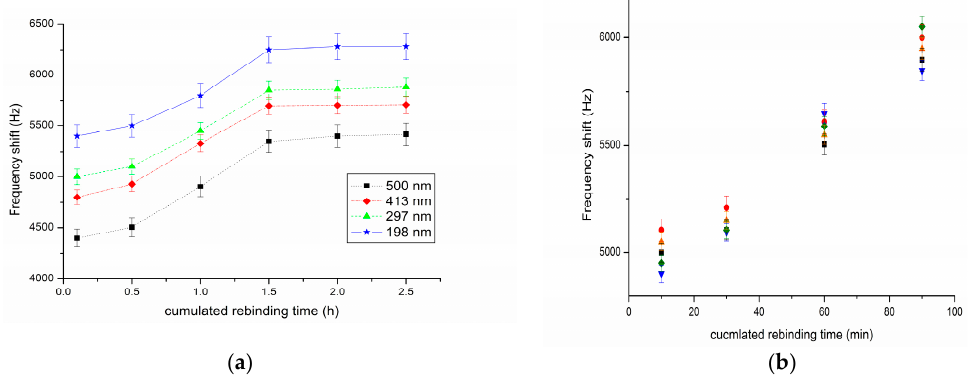
Figure 3. ( a ) Frequency shift (absolute value) of four sensors with different PSMA-MIP film thicknesses to 10 ng mL − 1 PSMA vs. rebinding time; and ( b ) reproducibility characterization (different colors represent independent sensor by the same fabrication process).